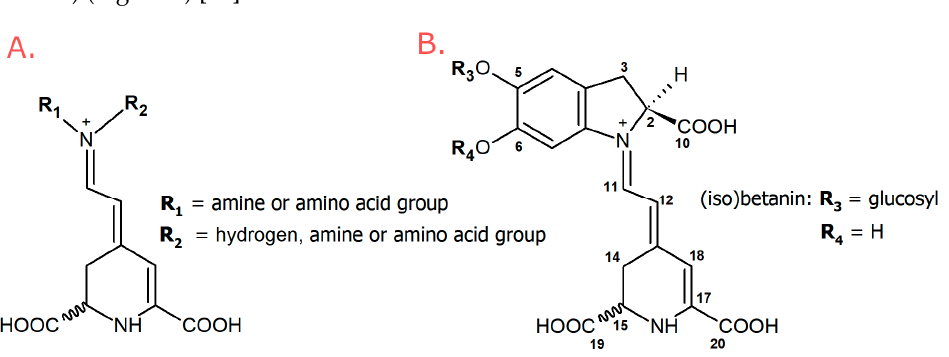
Figure 1. General structures: ( A ) betaxanthins, ( B ) betacyanins. The simplest betacyanin is betanidin (betalamic acid + cyclo -DOPA). The most widespread betacyanin among plants is betanidin-5- O - β -glucoside, commonly named betanin [17–22]. Betaxanthins are condensation products of betalamic acid with amines or amino acids. The most common betaxanthins are vulgaxanthin I (glutamine-Bx) and indicaxanthin (proline-Bx), found in yellow beet and cactus pear, respectively.